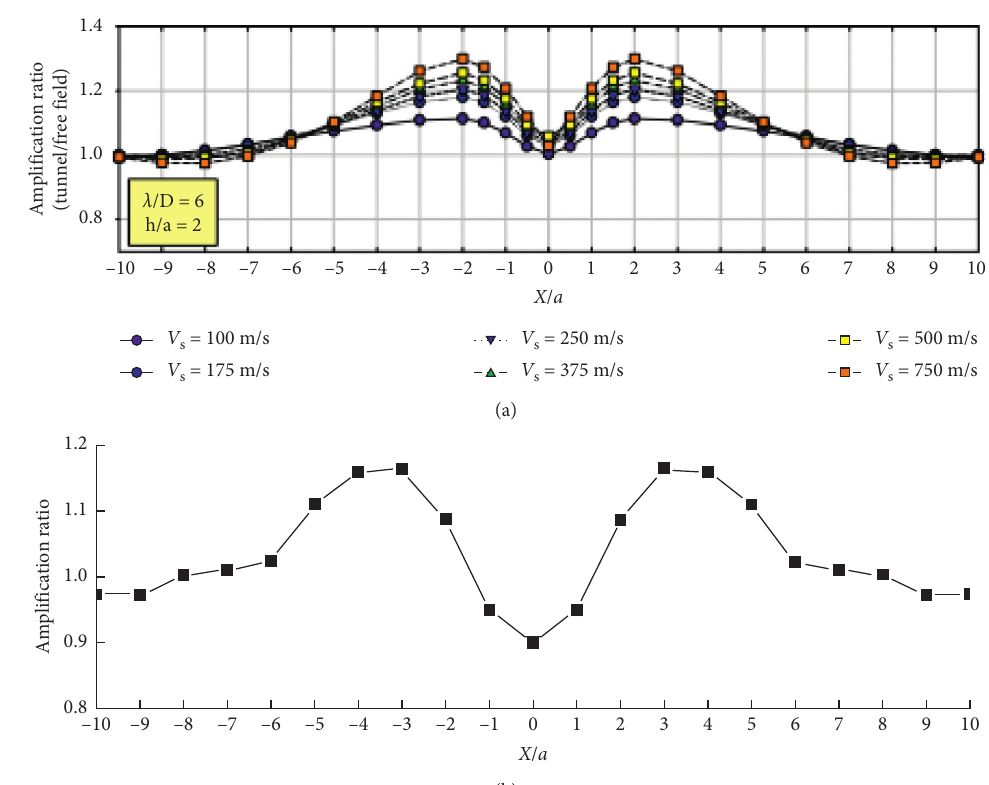
Figure 6: Comparison of simulation results. (a) Results in Reference [15]. (b) Simulation results of this paper.